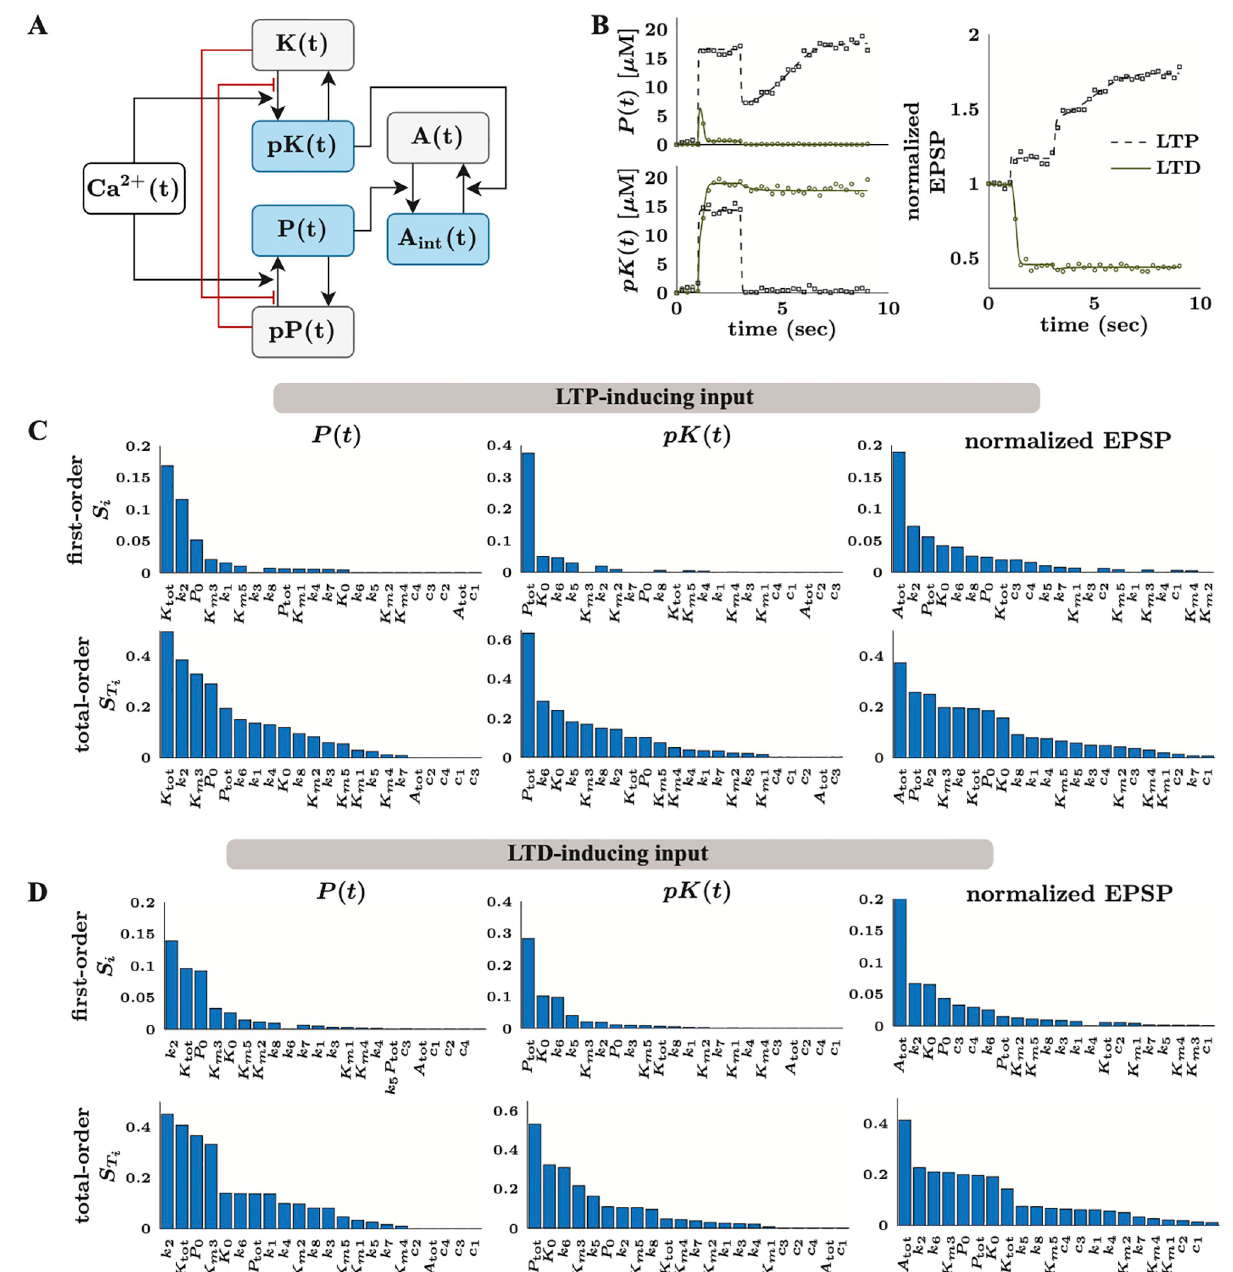
Fig 8. Parameter estimation for a coupled kinase-phosphatase switch for long-term potentiation and long-term depression in neurons as a function of calcium input. ( A ) Network diagram of the simplified coupled kinase-phosphatase signaling model where calcium Ca 2+ ( t ) acts as the input. ( B ) Trajectories of the three state variables in response to long-term potentiation (LTP; pulse of Ca 2+ ( t ) � 4.0 [ μ M] from 2 � t � 3 (sec)) and long-term depression (LTD; pulse of Ca 2+ ( t ) � 2.2 [ μ M] from 2 � t � 3 (sec)) inducing calcium inputs. The calcium level is set to a baseline of Ca 2+ ( t ) � 0.1 [ μ M] before and after stimulus. We compute normalized EPSP by normalizing A ( t ) to its initial condition as described in [57]. The synthetic noisy data for the LTP and LTD cases are indicated by the black square and green circle marks, respectively, with the noise covariance equal to 1% of the variance of the data. ( C and D ) Sobol sensitivity indices for all free model parameters in response to LTP-inducing and LTD-inducing inputs, respectively. The quantities of interest are the steady state values of each state variable. We show both the first-order sensitivity indices S and the total- i order indices S . We select a reduced set of free parameters by choosing the parameters whose first-order sensitivity index is greater than 0.05, e.g., S i > T i 0.05. This gives us the same set of free parameters, θ ¼ ½ k , k 6 , K 0 , P 0 , K tot , P tot , A tot ] > , for both the LTP and LTD cases. Remaining model parameters 2 f are fixed to the nominal values in S4